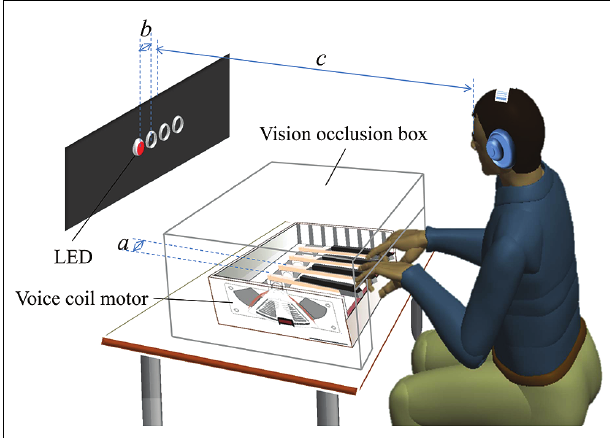
FIGURE 1 |A schematic diagram of the experimental apparatus and setup. Four lever-shaped keys were motorized using flat voice coil motors (VCMs) and placed under computer control.The keys were spaced 6.5 cm centerline to centerline (dimension a ).Visual stimuli were presented by the lighting of four horizontally positioned red LEDs spaced 5 cm apart (dimension b ) and haptic stimuli were provided by the injection of an upward half-sinusoid pulse in the reference position of the key. A participant sat and rested her/his ring and index fingers of both hands on the keys.The center of the four LEDs was about 90 cm away from the participant’s eyes (dimension c ). She/he was allowed to adjust the height of the chair for comfort and the participant’s view of her/his hands was occluded using a box.White noise was presented through